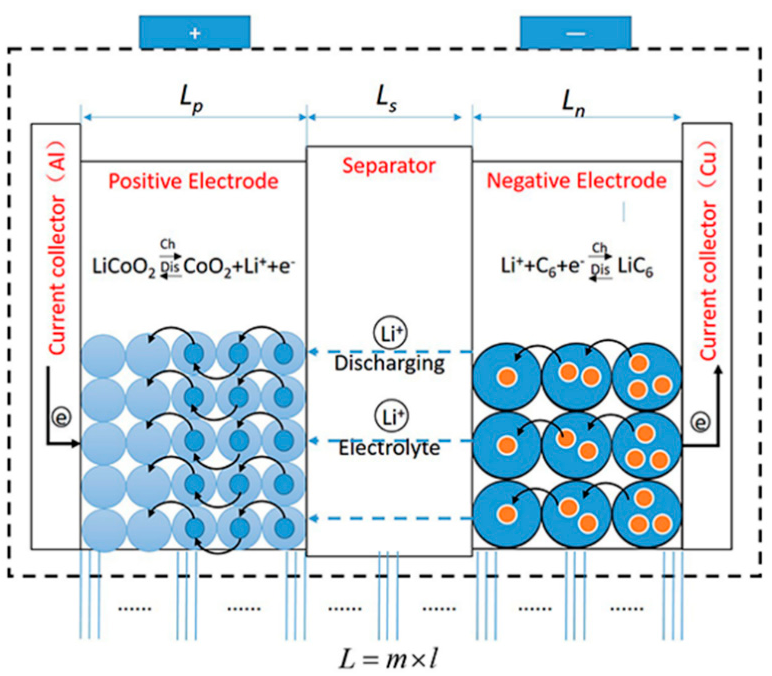
Figure 2. Schematic illustration of a lithium ion battery model.